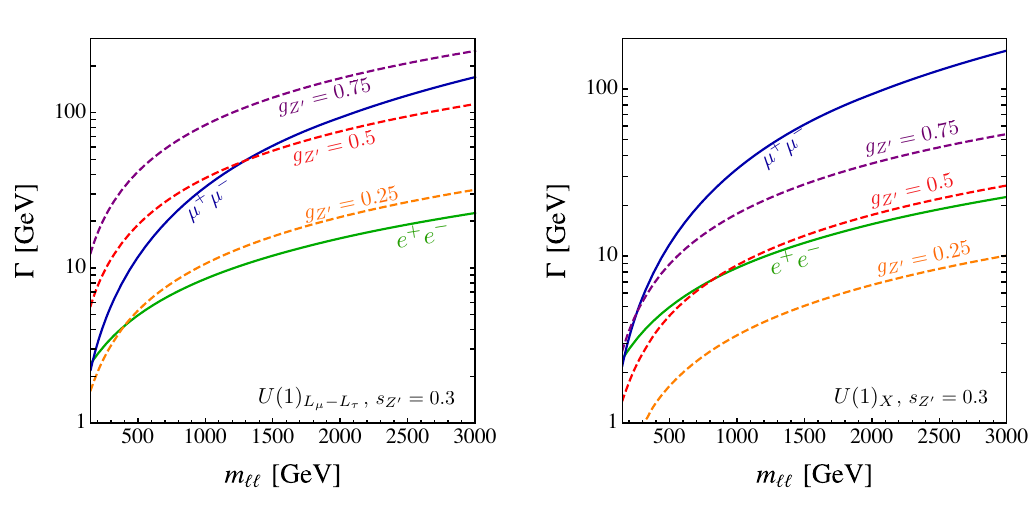
= 0.3 and U ( 1 ) models for s X L µ − L τ Z (cid:48) = m (cid:96)(cid:96) . Z (cid:48)